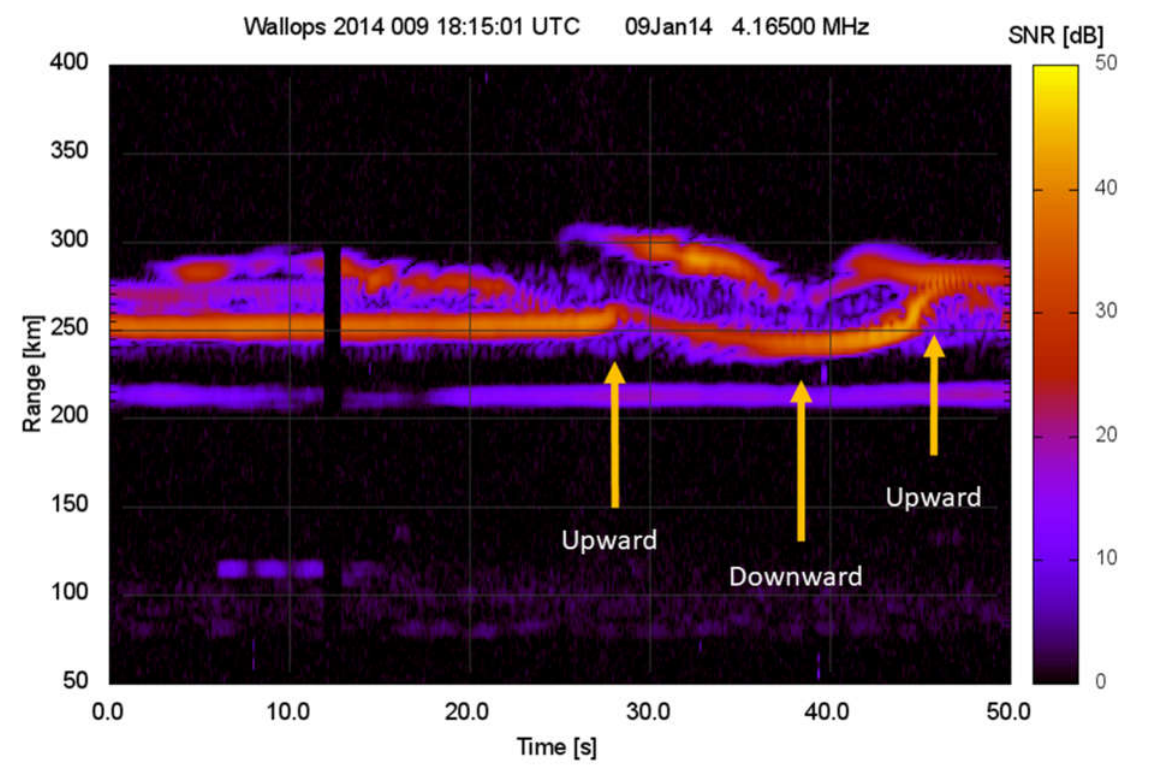
Figure 7. Fixed frequency ionogram when ORB-1 HAAW arrives at the fixed frequency O-mode observation altitude. Arrival times of the initial upward and large amplitude downward and upward plasma displacements are marked ‘Upward’, Downward’, and ‘Upward’, respectively.